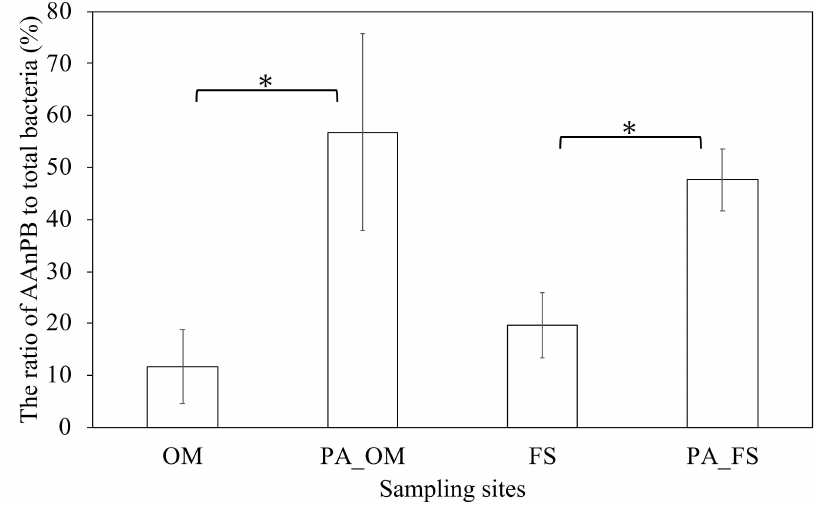
Figure 4. Free-living and particle-attached AAnPB ratio to the total bacteria (%) in Tama River. PA indicates ‘particle-attached’ and the others (unlabeled) are free-living. Asterisks represent p < 0.01 of the two-tailed t -test. Compared to AAnPB in lakes and ponds, the ecological knowledge of AAnPB in rivers is quite limited. Ruiz-Gonz á les et al. [26] described the distribution and abundance of AAnPB in the Ebro River located in the northern third of the Iberian Peninsula and indicated that the AAnPB abundances in the river changed seasonally from < 1% in winter to 14% in autumn, suggesting their dramatic change depending on the seasonality. In the investigation of AAnPB in the ocean, there were wide variations of their abundances among various areas in the same season [4], which possibly resulted from the various geochemical parameters, for example, organic matter concentration and nutrient conditions and so on. In the present study, the absolute abundances of the free-living AAnPB in the river ranged from 6.1% to 19.6% of the total bacteria. The result apparently showed the variety of the AAnPB abundances in the di ff erent areas of the river but in the same